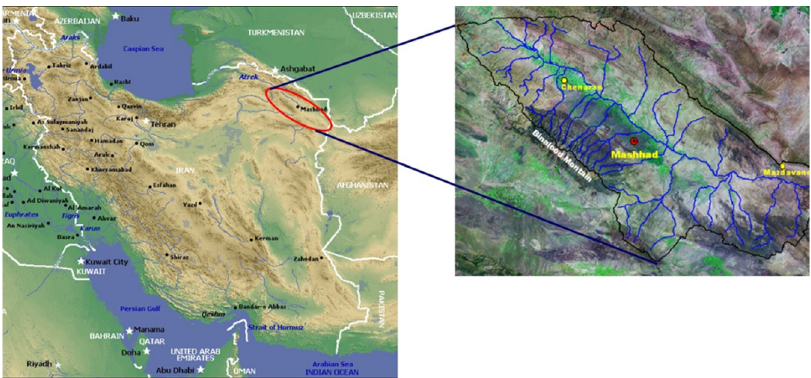
Figure 3. Location of the Kashafroud watershed in North-Eastern Iran.